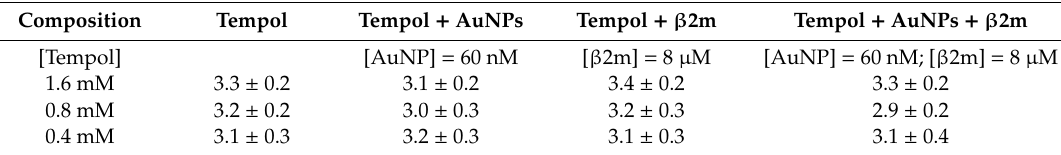
Table 1. Rotational correlation time ( τ c / 10 − 11 s) of Tempol at the indicated concentrations and di ff erent solution compositions obtained from ESR measurements at 298